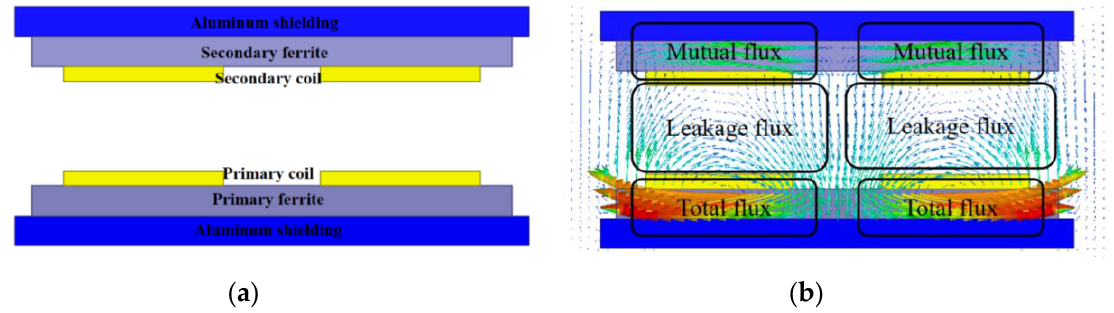
lar wireless coupler.